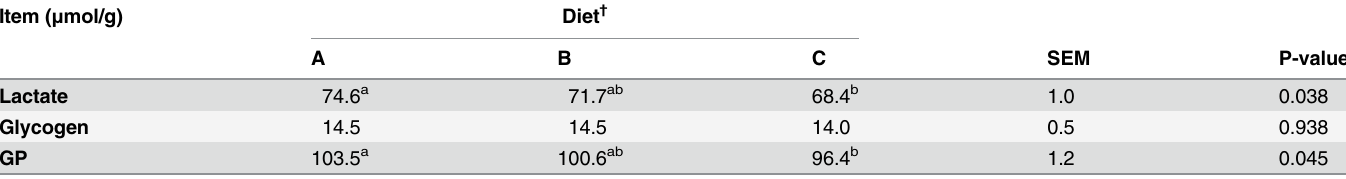
Table 5. Effect of dietary energy sources on muscle glycolytic potential of finishing pigs at 45 min postmortem. Item ( μ mol/g)